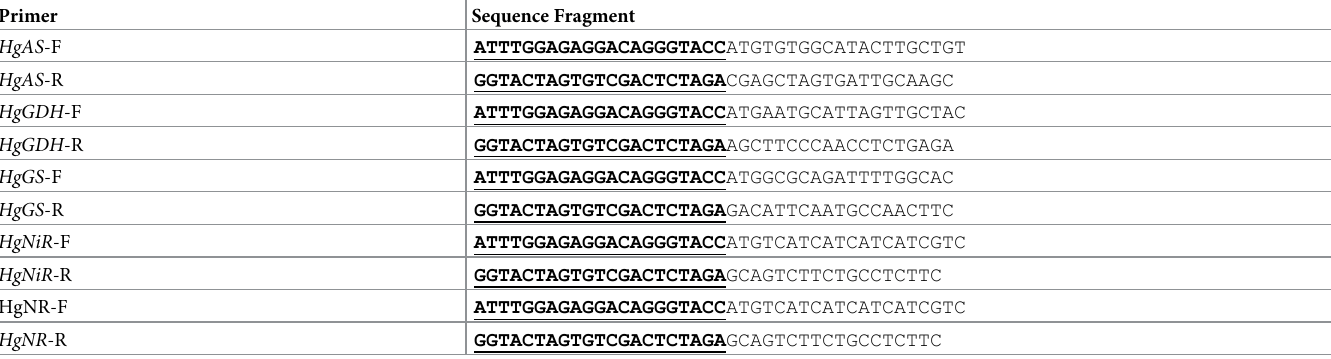
The underlined portion of each primer indicates the restriction enzyme sites for Kpn I and Xba